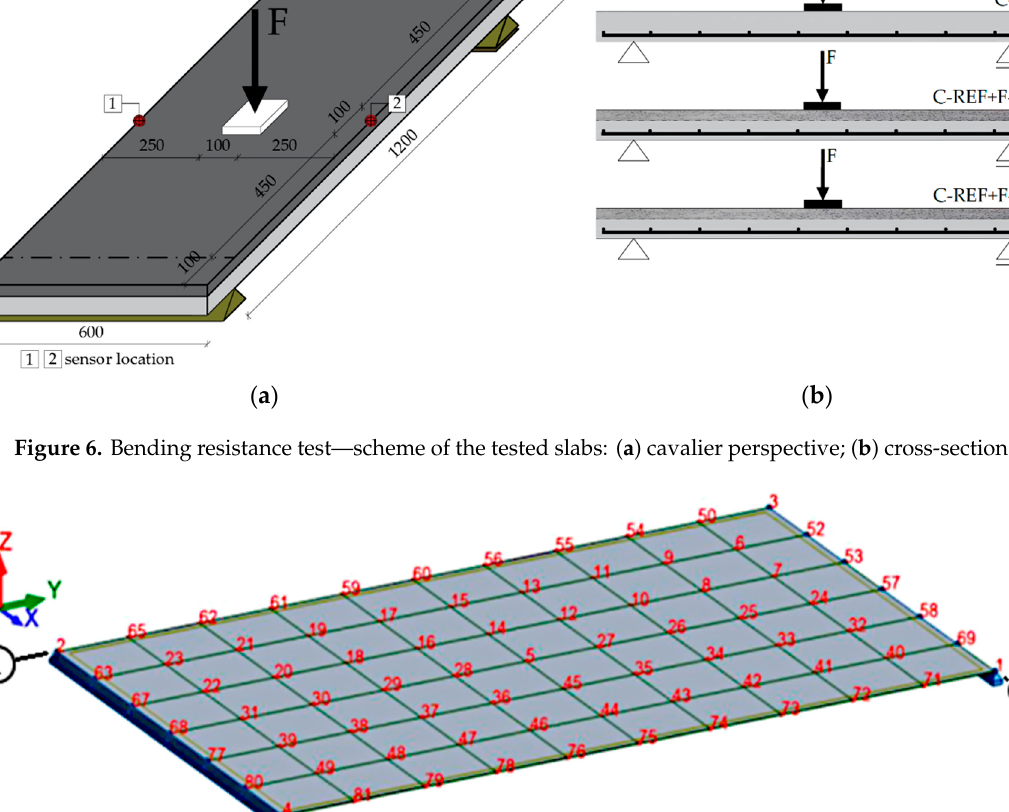
Figure 6. Bending resistance test—scheme of the tested slabs: ( a ) cavalier perspective; ( b ) cross- section.